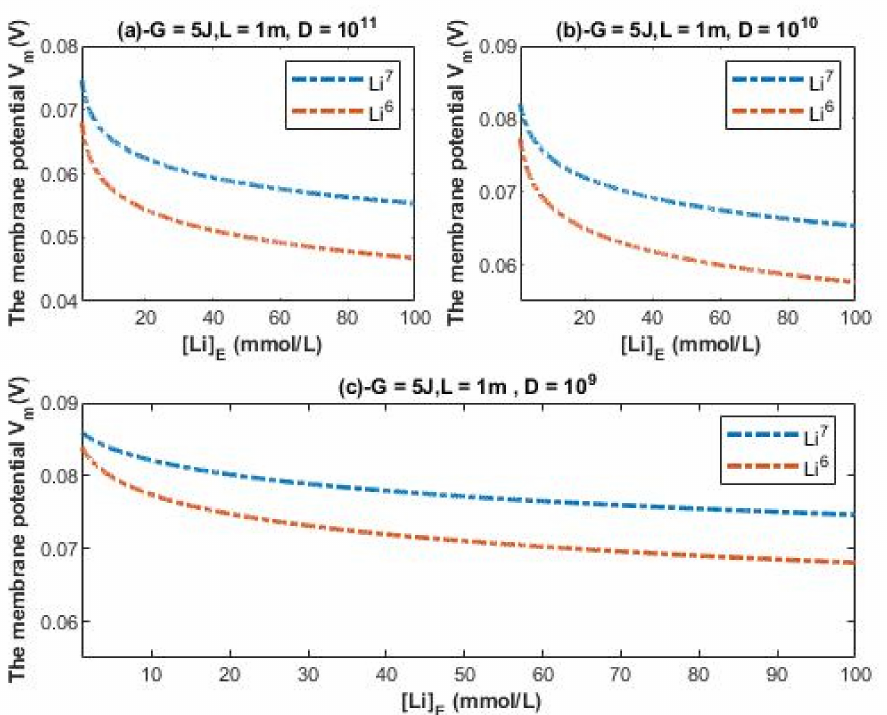
Figure 10. The figure represents the influence of quantum tunneling of lithium isotopes on the resting membrane potential according to the concentration range 1–100 mmol/L for extracellular lithium ions. The influence of lithium isotopes on the resting membrane potential is assessed under different values of sodium channels density D and by setting G = 5 J and L = 1 m. In the graph ( a ), D = 10 11 channels/cm 2 , in the graph ( b ), D = 10 10 channels/cm 2 , and in the graph ( c ), D = 10 9 channels/cm 2